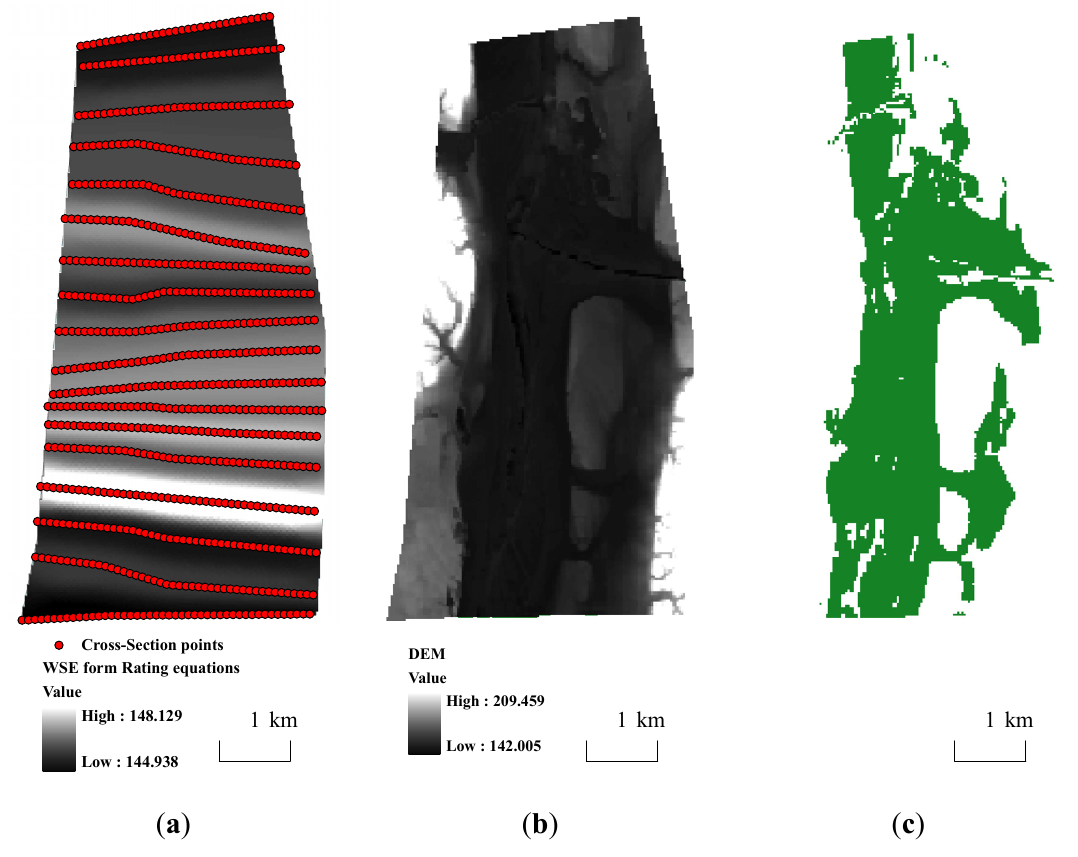
Figure 7. Flood map generation: c = a ≥ b . ( a ) Water Surface Elevation interpolated by inverse distance weight (IDW); ( b ) digital elevation models (DEM); ( c ) Flood inundation